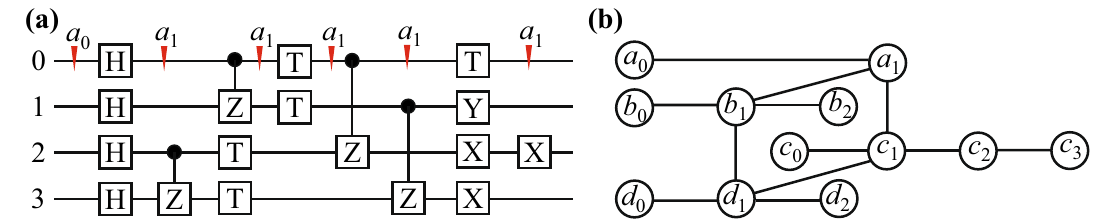
Figure 3. An illustration example of mapping a quantum circuit to the undirected graphical model. ( a ) A quantum circuit adapted from the part of Fig. 1, ( b ) the corresponding undirected graph. The triangle symbols are used to explain the change of Boolean variables along the worldline of qubit 0. Note that since the cross lines are considered as one line in the undirected graph, the vertices are rearranged to avoid the false